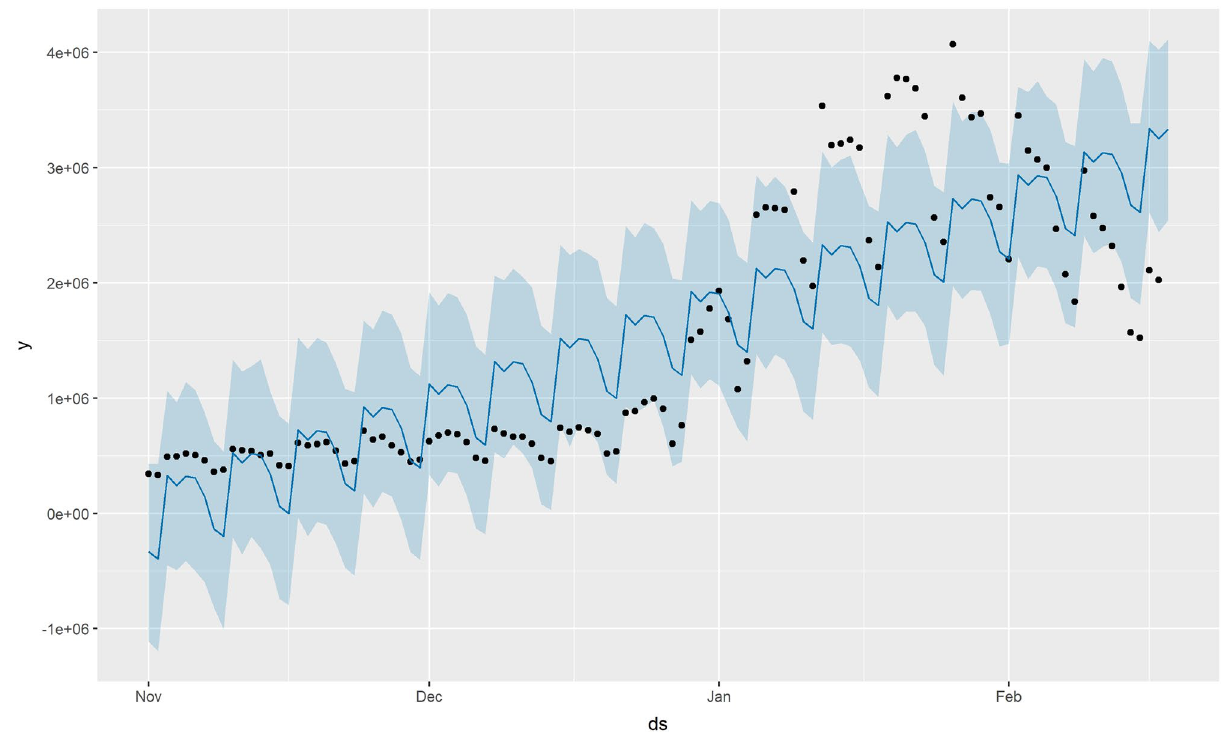
Figure.8. Prediction performance of the Prophet model.